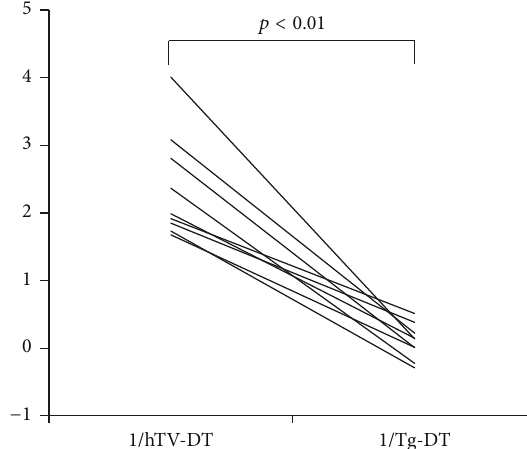
Figure 3: Comparison of the reciprocal of hTV-DT and the reciprocal of Tg-DT in the patients without RAI. hTV-DT: the preoperative hypothetical tumor volume-doubling time; Tg-DT: the postoperative thyroglobulin-doubling time. The 1/Tg-DT values were significantly smaller than the 1/hTV-DT values in all patients ( 𝑝 < 0.01 ), suggesting a postoperative decrease in tumor growth or even regression in patients without administration of